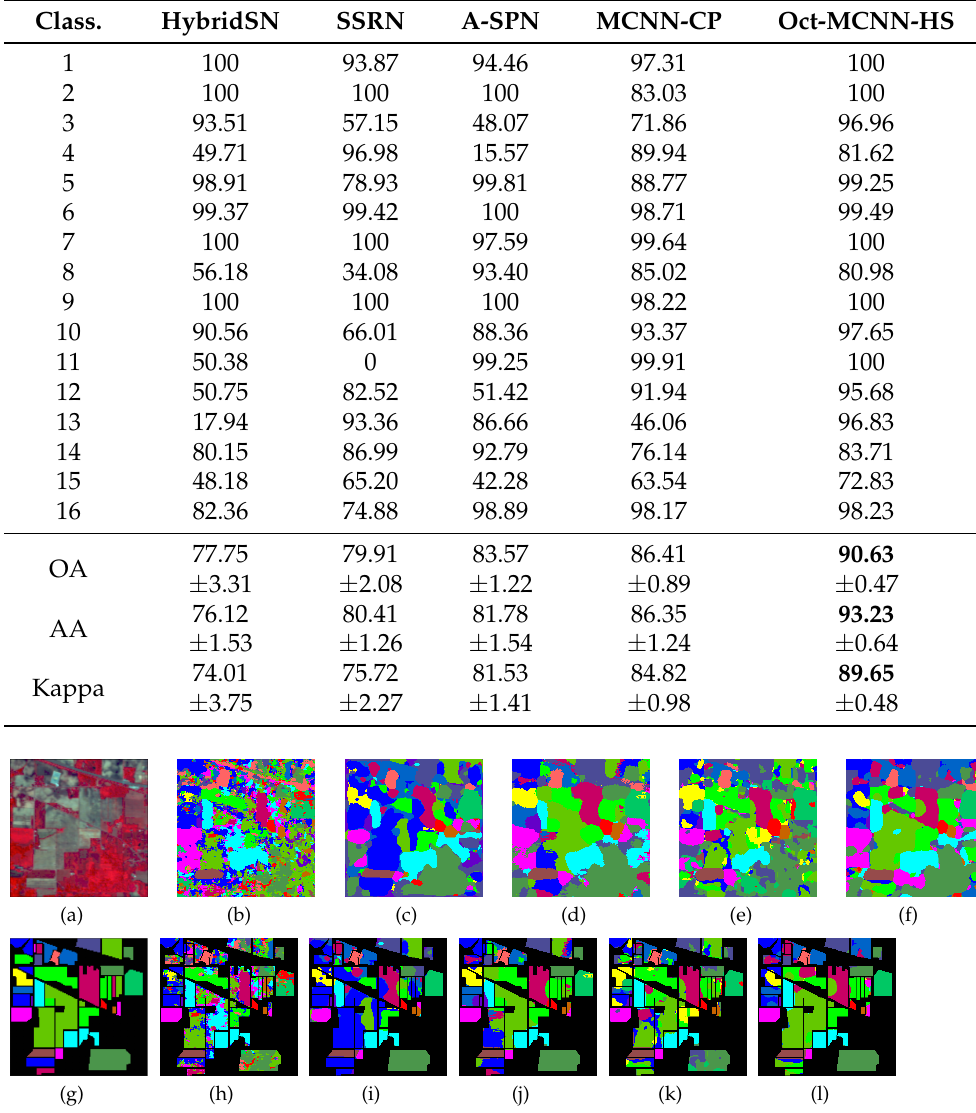
Figure 4. Classification maps generated by all of the competing methods on the Indian Pines data with 80 training samples; ( a , g ) are false-color images and ground-truth maps , respectively, while ( b – f ) and ( h – l ) are the results of HybridSN, SSRN, A-SPN, MCNN-CP, and Oct-MCNN-HS,